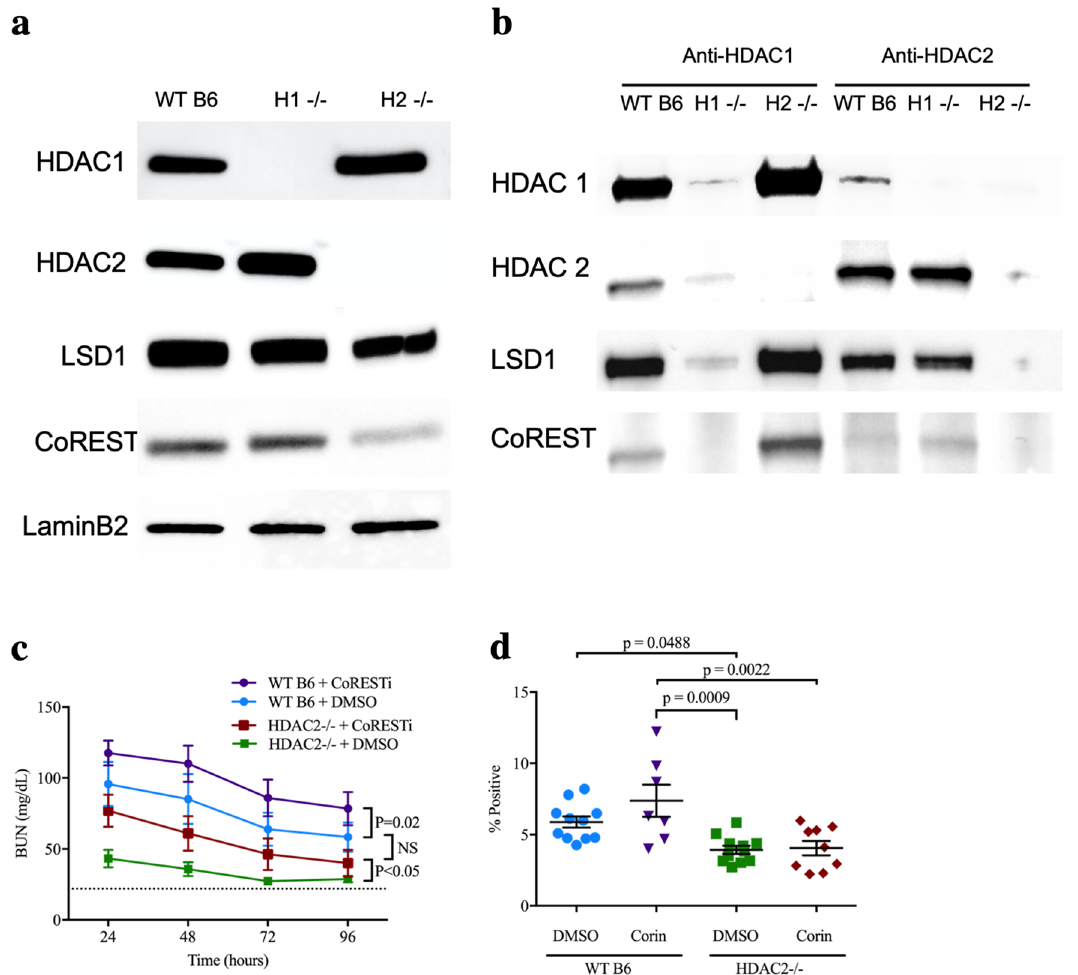
Figure 6. ( a ) Western blots using nuclear extracts from primary RTEC cultures from WT B6, HDAC1-/- (H1-/-) and HDAC2-/- mice (H2-/-); composite image displayed here, original blots, including MS standards, displayed in Suppl. Fig. 6a. ( b ) Western blots following immunoprecipitation with anti-HDAC1 or anti-HDAC2 antibody, using cells as described in panel ( a ). Composite image displayed here, original blots, including MS standards, are displayed in Suppl. Fig. 6b. ( c ) BUN and ( d ) computerized scoring of renal fibrosis with Sirius Red staining at 28 days in WT mice treated with CoRESTi (10 mg/kg at 16- and 1-h pre-ischemia) or vehicle (DMSO). Data are expressed as mean ± SEM for ( c ) and mean ± SD for ( d ). Significance was determined with 2-way ANOVA with Tukey’s post-hoc